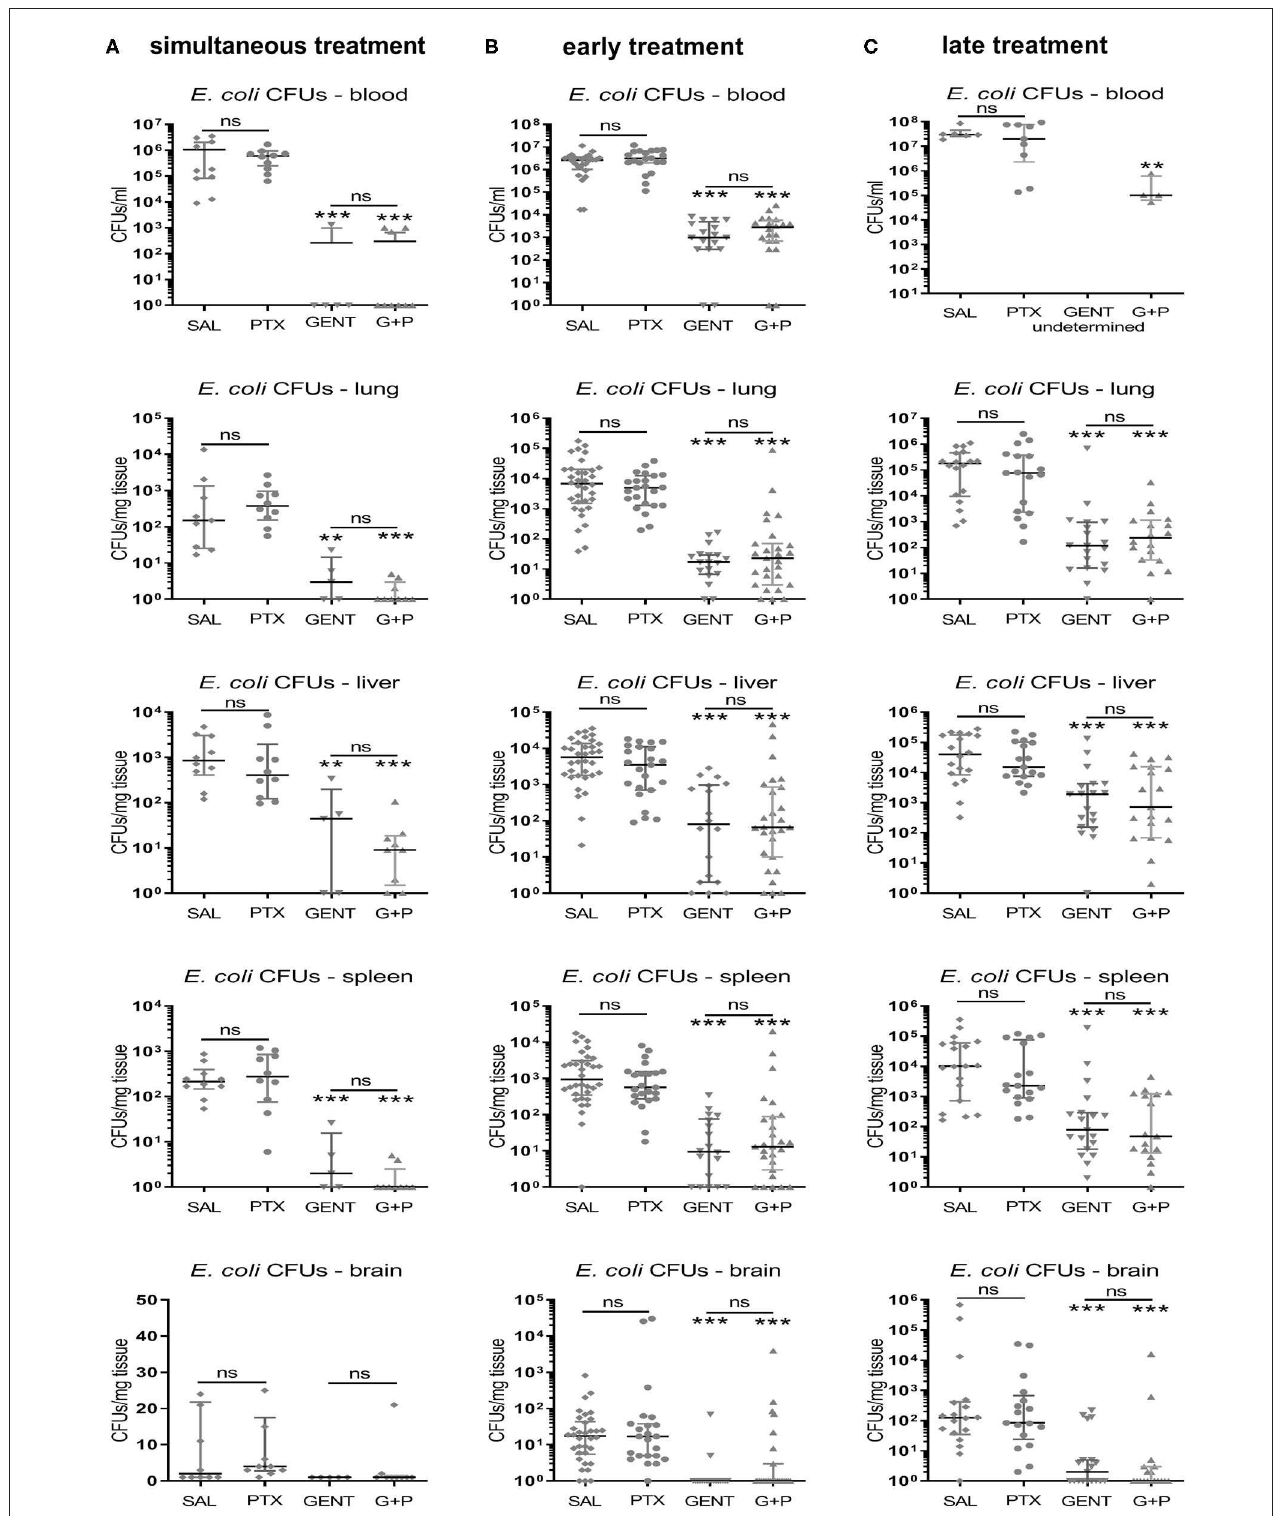
FIGURE 7 | PTX did not increase E. coli bacterial growth in neonatal mice. Neonatal mice < 24h old were injected IV with E. coli 10 5 CFU/g body weight, followed by (A) simultaneous (0h, n = 9–10), (B) early (1.5h, n = 17–34), or (C) late (4h, n = 17–19) IP injection of saline control (SAL), GENT, PTX, or GENT + PTX (G + P). After an additional 4h of incubation, i.e., 4, 5.5, or 8h from the time of sepsis initiation, mice were euthanized and blood and homogenized organ tissue serially plated for